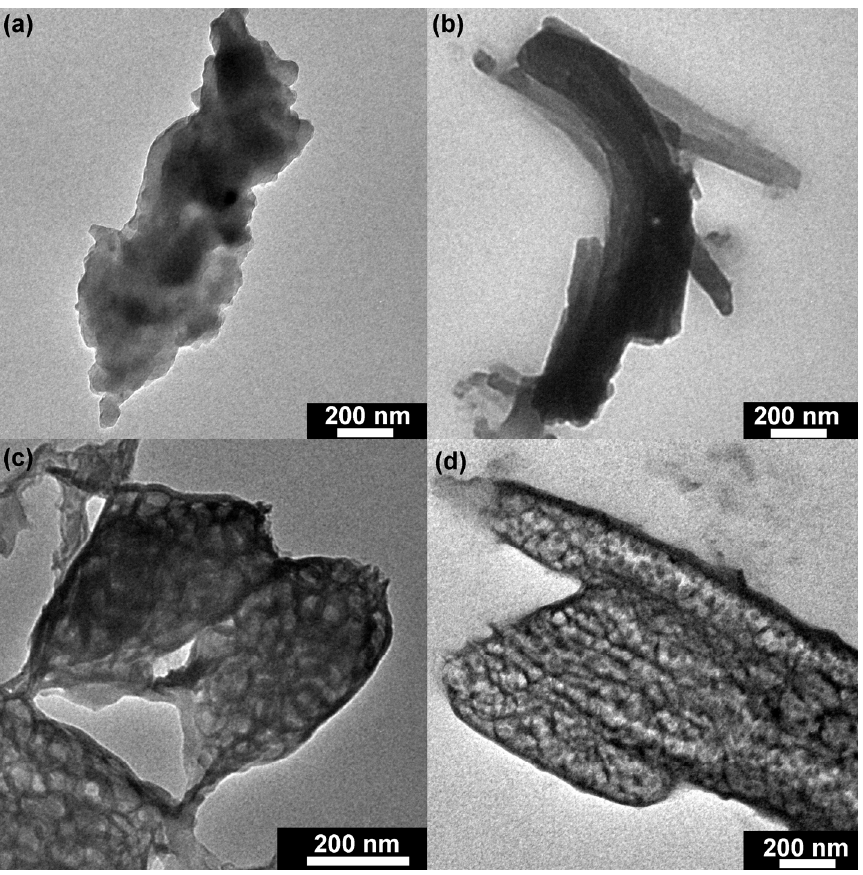
Figure 3. Transmission electron microscopy ( TEM) of TMP synthesized by different M:TMC